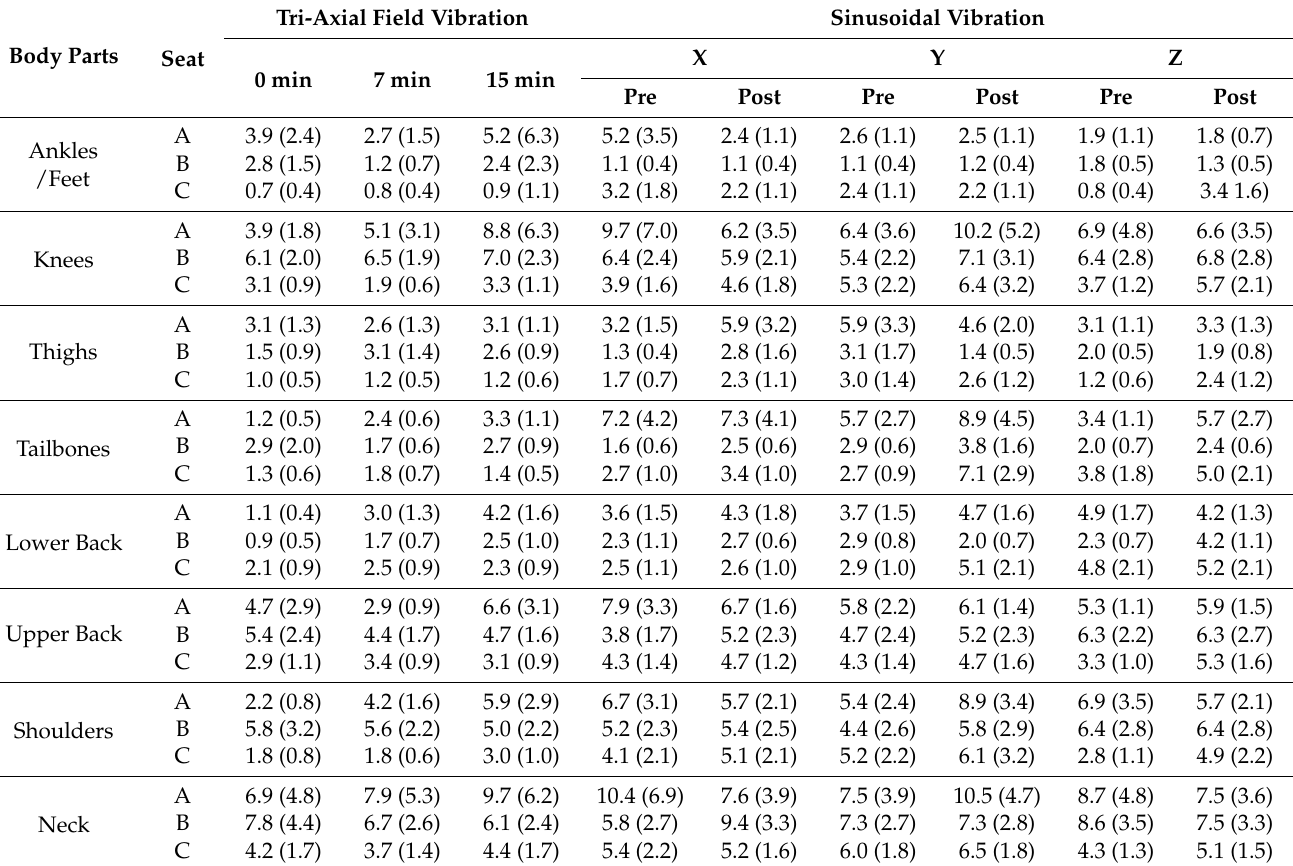
Table 5. Mean (Standard error) perceived discomfort in eight body parts when exposed to the 15-min tri-axial field vibration and sinusoidal vibration (10 min per each of X, Y, Z axes) ( n =